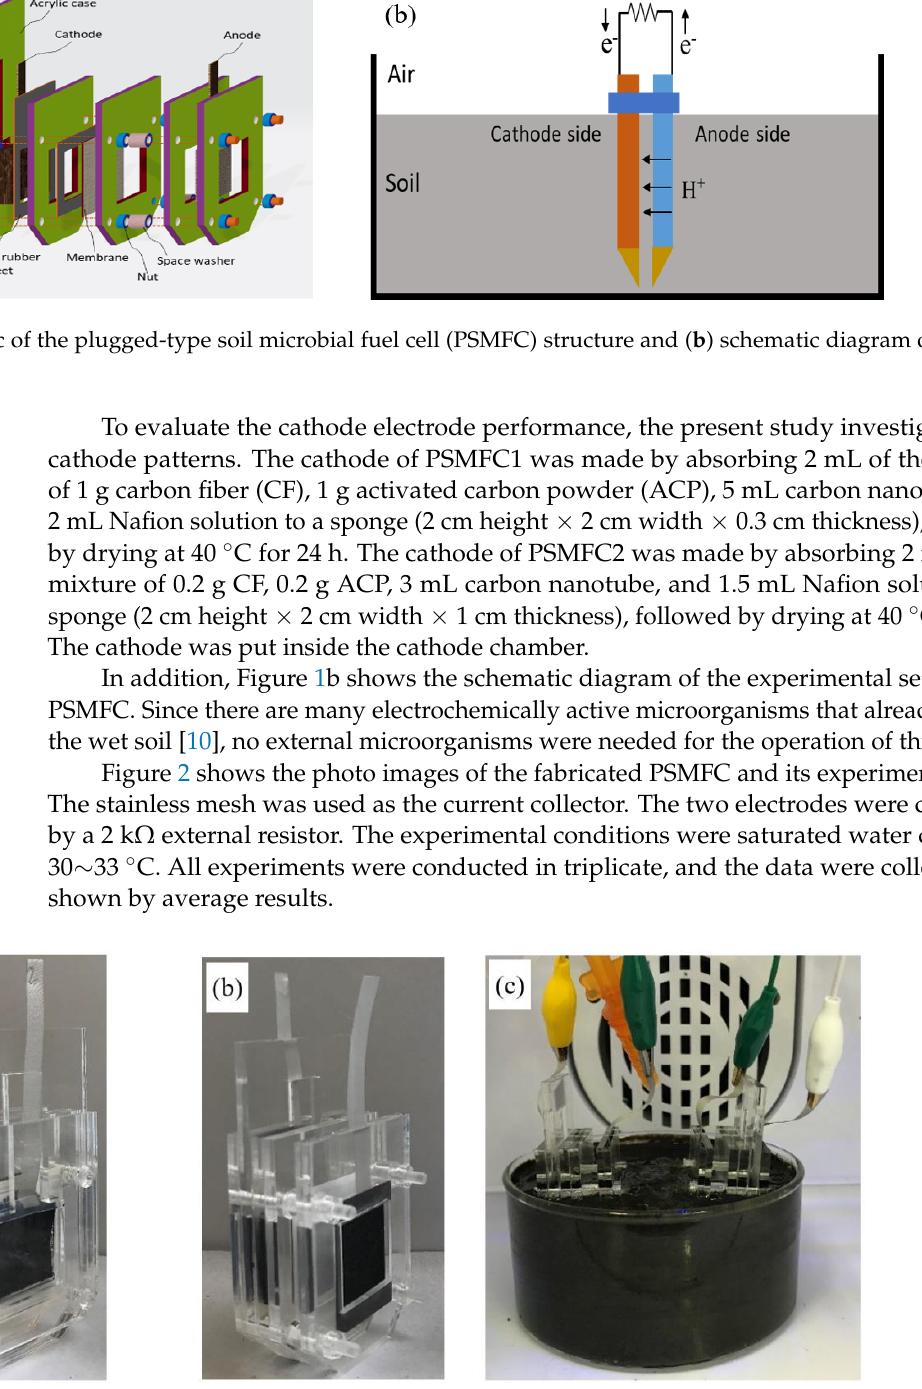
Figure 1. ( a ) Schematic of the plugged-type soil microbial fuel cell (PSMFC) structure and ( b ) schematic diagram of the experimental setup.